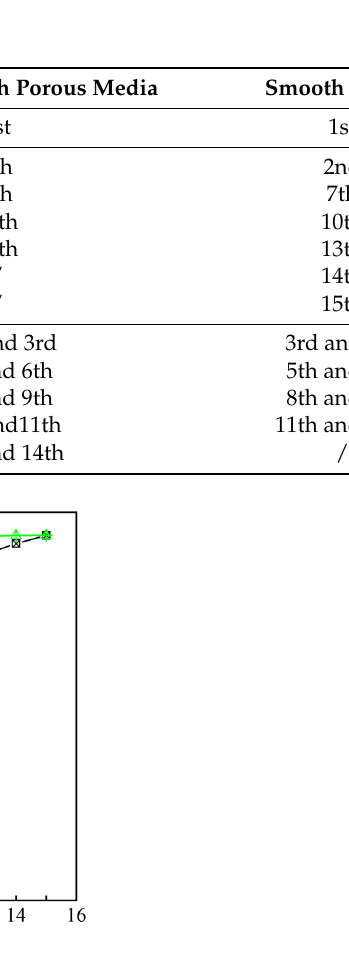
Figure 12. Relative energy distribution of modal